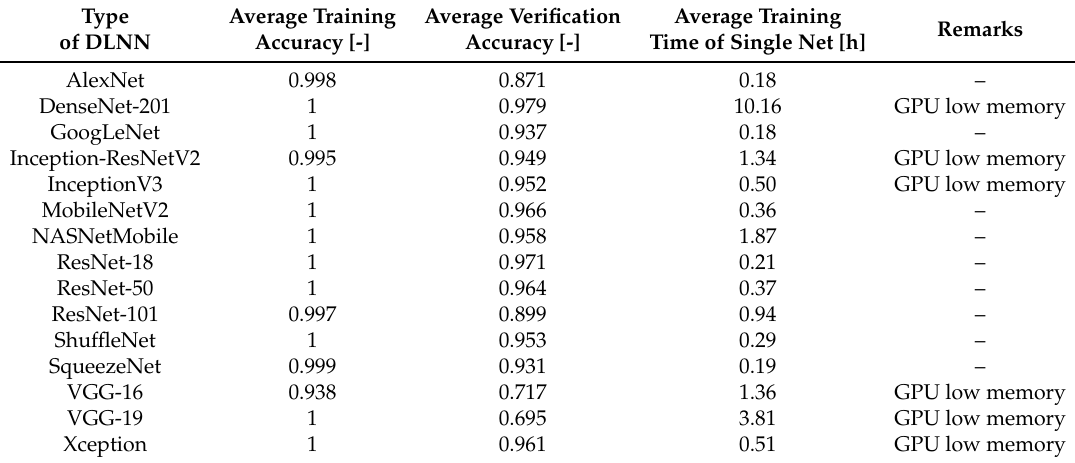
Table 4. Comparison of different